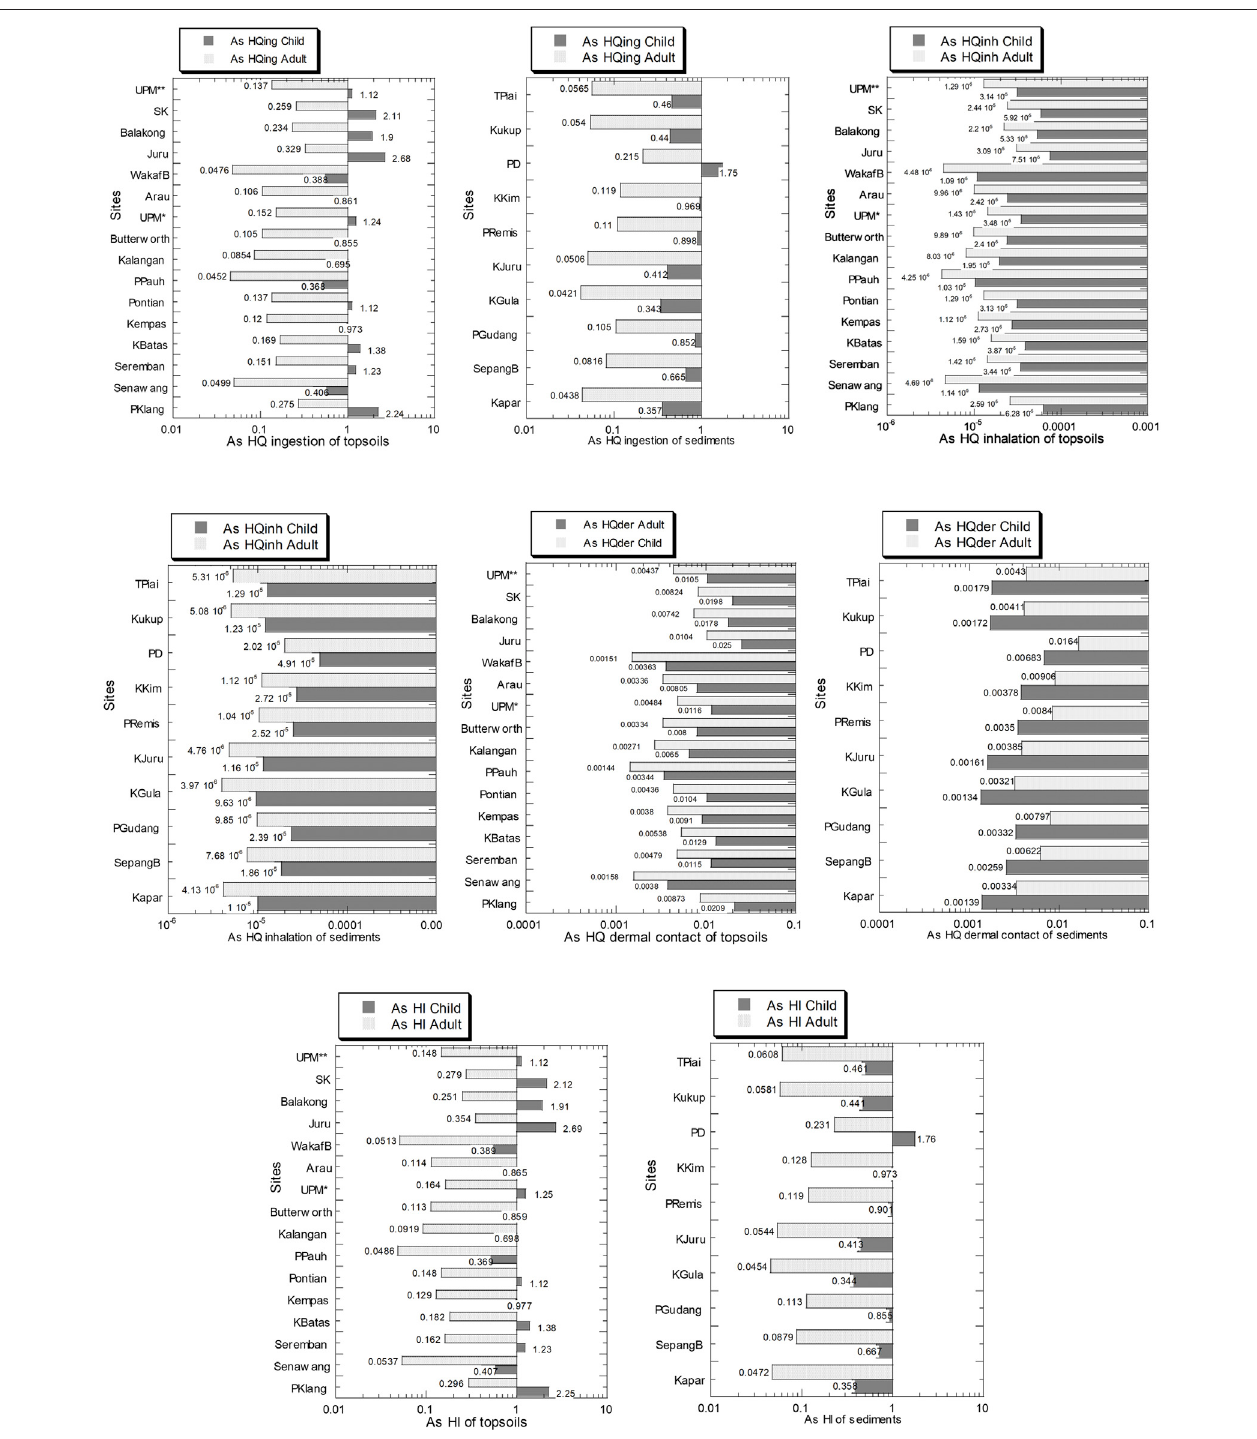
FIGURE 10 | As hazard quotient values of ingestion (HQ ing ), inhalation (HQ inh ), and dermal contact (HQ der ) pathways in the soils (numbers in white circles (1 – 16) in Figure 1 ; S1 – S16 in Supplementary Table S1 ) and mangrove sediments (numbers in black circles (1 – 10) in Figure 1 ; M1 – M10 in Supplementary Table S1 ) from Peninsular Malaysia, in children and adults. The X -axes are based on a logarithmic scale.